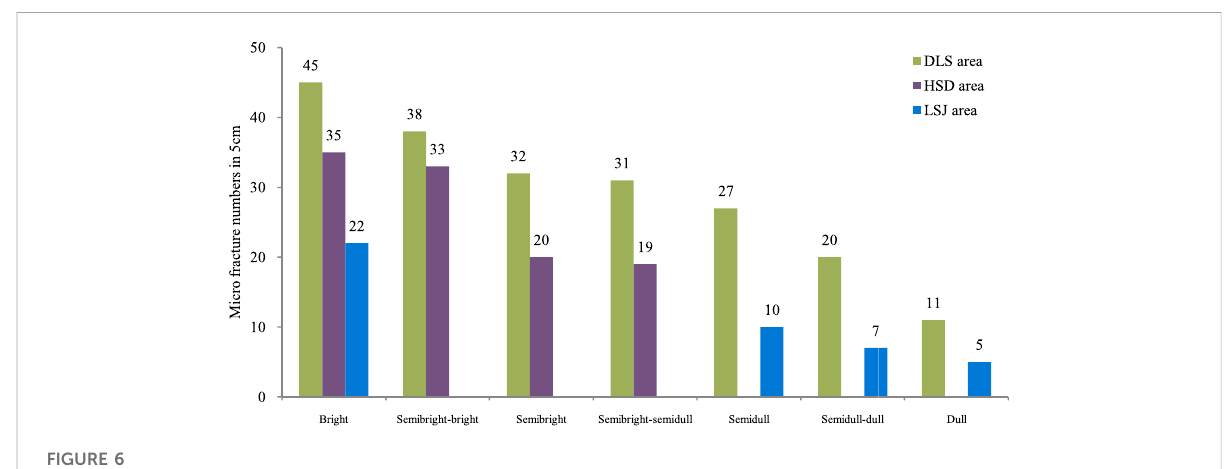
FIGURE 6 Histogram of microfracture density with coal